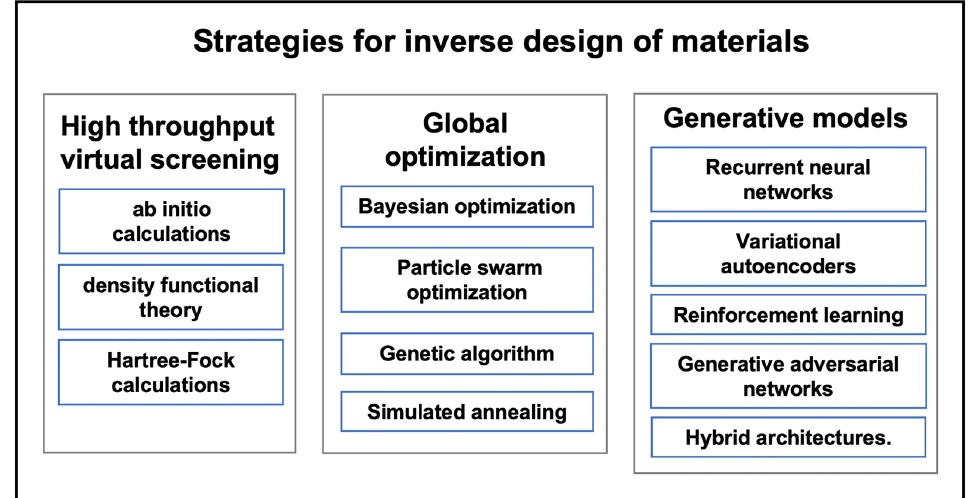
Figure 2. Strategies for inverse design of materials.